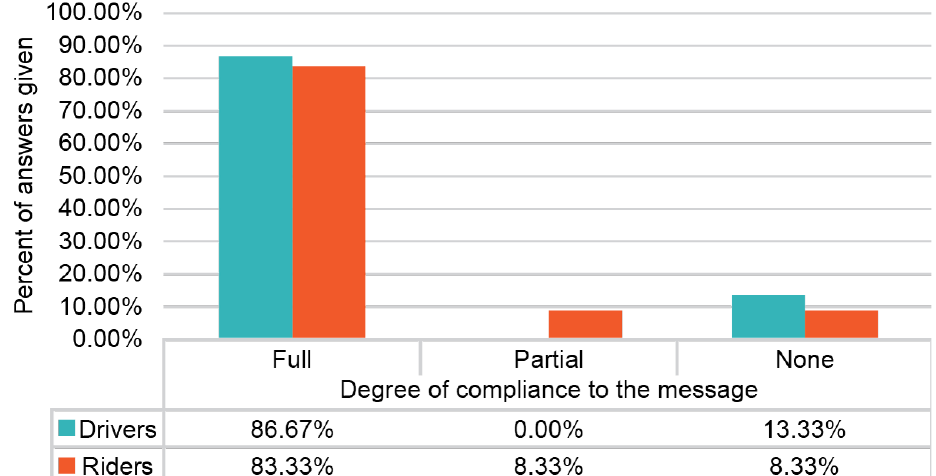
Figure 16. Degree of compliance for the scenario “ VMS ” .